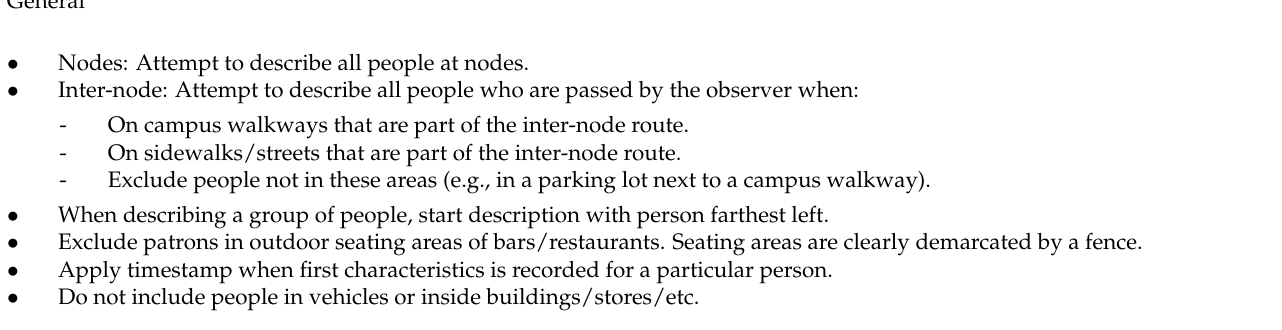
Table 1. Rules used for training and obtaining outcomes from videos.